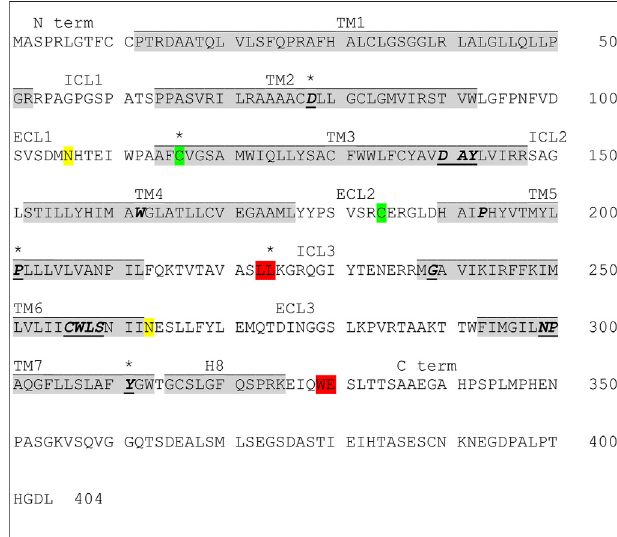
FIGURE 1 | Protein sequence of GPR143 with highlighted features and residues. Grey: transmembrane domains (TM) as predicted by GPCRdb (Isbergetal.,2015,2016;Kooistraetal.,2021);yellow:potential glycosylation sites N106 in ECL1 and N263 in ECL3 (Samaraweera et al., 2001); green: highly conserved cysteine residue in TM3 (C3.25) which might form a disul fi de bond with C184 in extracellular loop 2 (ECL2); red: sorting signals for intracellular localization (dileucine motif (L223/L224) in the intracellular loop 3 (ICL3) and tryptophan-glutamic acid doublet (W329/E330) in the C terminal tail) (Piccirillo et al., 2006). Conserved residues found in class A GPCRs or similarmotifsarebold,italicandunderlined,motifscommoninclassBGPCRs are bold and italic, residues known to cause ocular albinism type 1 when mutated are marked with an asterix (for references see main